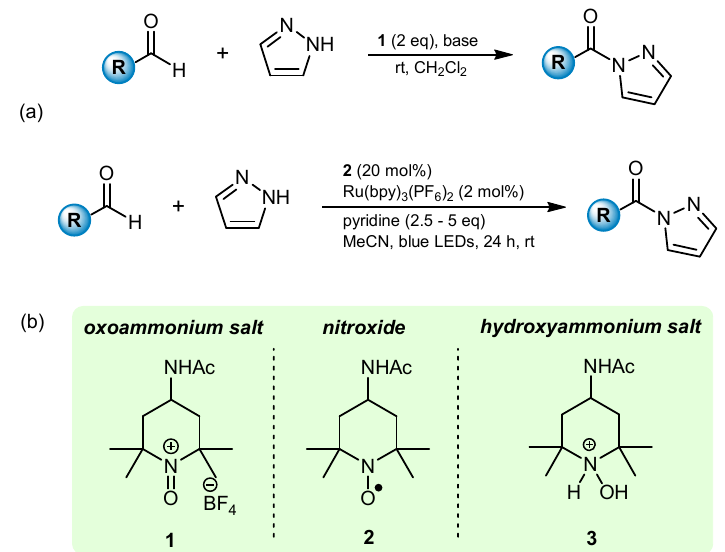
Figure 1. ( a ) Oxidative amidation of aldehydes with pyrazole to prepare acyl pyrazoles. ( b ) Oxoam- monium salt 1 , and its nitroxide and hydroxylammonium analogs 2 , and 3 .